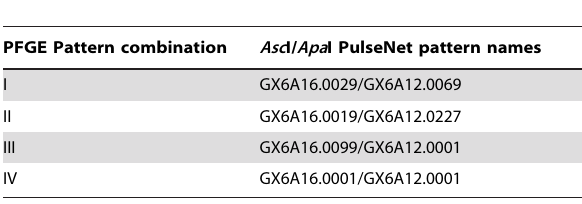
Table 2. PFGE pattern combinations associated with the outbreak.